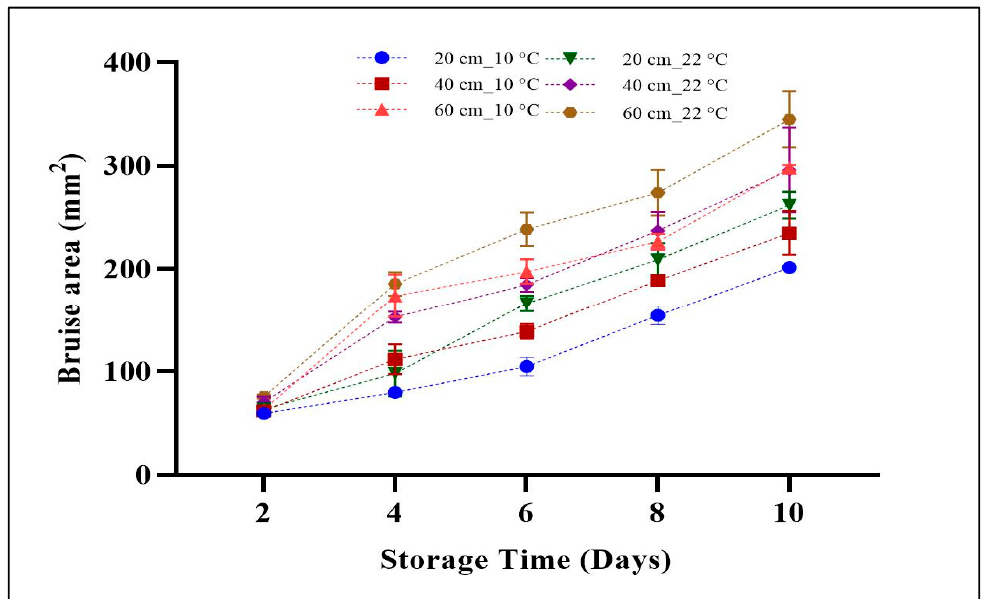
Table 1. Linear regression equations of bruise area ( BA ), weight loss (WL), firmness (F), total solu- ble solids (TSS), and lycopene in relation to storage duration (SD), temperature (T), and drop height (DH) as independent variables.